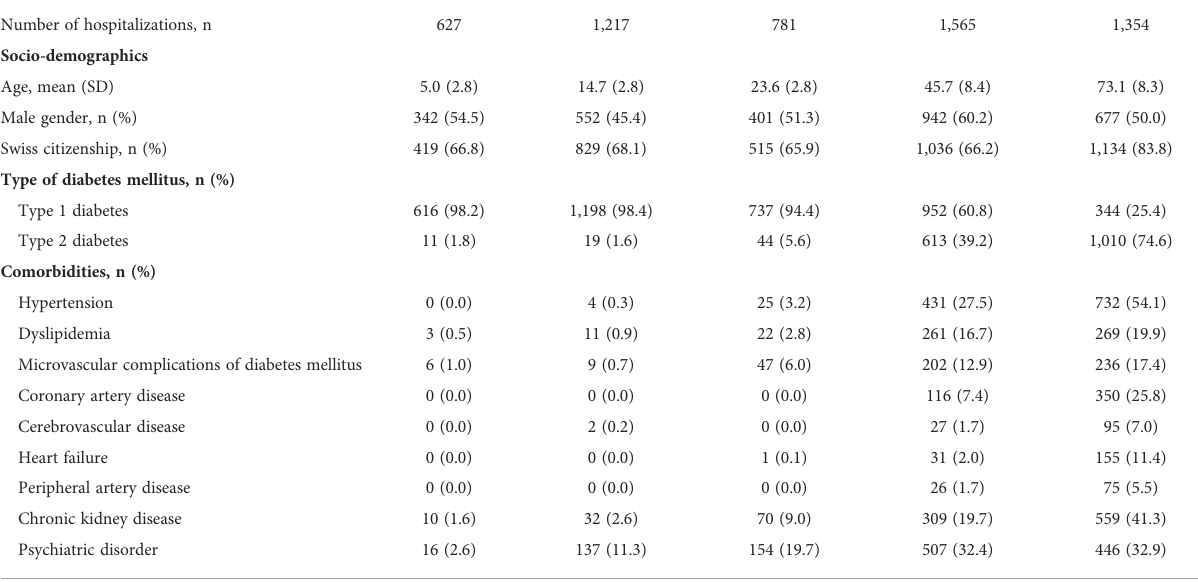
TABLE 1 - Baseline